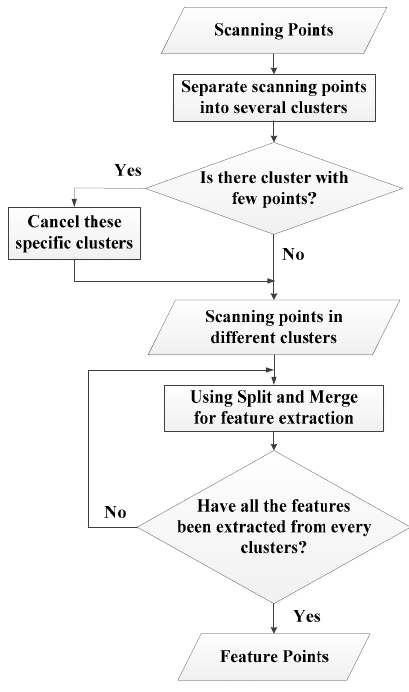
Figure 1 . Flow chart of feature extraction. Figure 1. Flow chart of feature